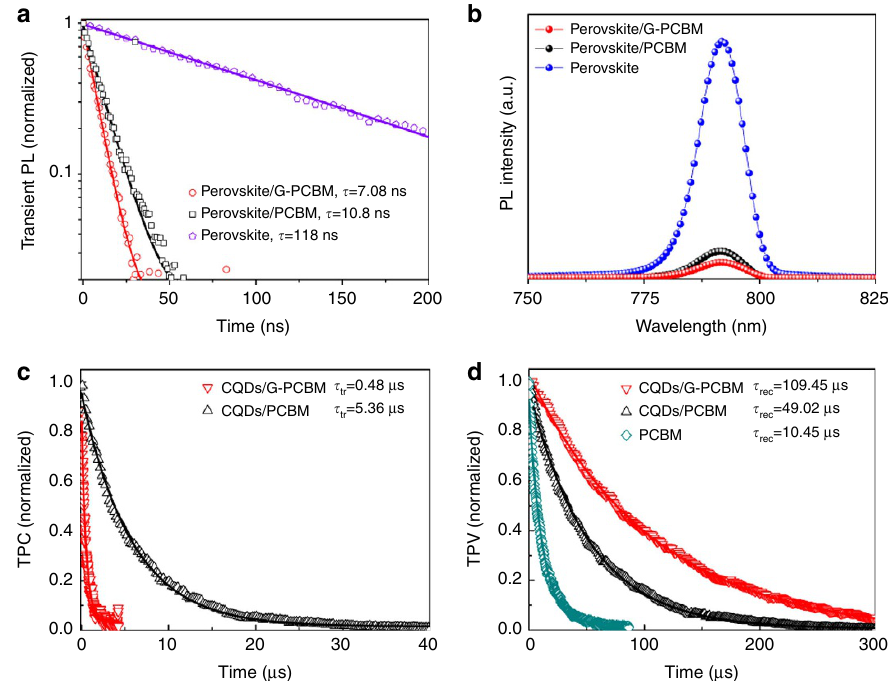
Figure 4 | Electron extraction and charge recombination properties. ( a , b ) TRPL decay curves and steady-state PL of MAPbI 3 films covered by fullerene derivative phenyl-C61-butyric acid methyl ester (PCBM) and N-doped graphene G-PCBM. Solid lines are fitted results with a double exponential decay. ( c , d ) The transient photocurrent and photovoltage decay curves of MAPbI 3 devices with CQDs/PCBM and CQDs/G-PCBM, respectively. NATURE COMMUNICATIONS|8:15330|DOI: